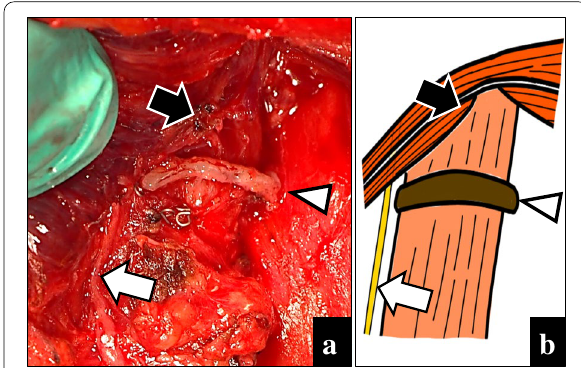
Fig. 3 Photograph and illustration showing the positions of the left recurrent laryngeal nerve and transected diverticulum. a Area of the left recurrent laryngeal nerve and nearby diverticulum transected transversally after diverticulectomy. White arrow: recurrent laryngeal nerve; arrowhead: staple line; black arrow: cricopharyngeal muscle. b Schema of the position between the recurrent laryngeal nerve and transected edge after partial myotomy. White arrow: recurrent laryngeal nerve; arrowhead: staple line; black arrow: cricopharyngeal